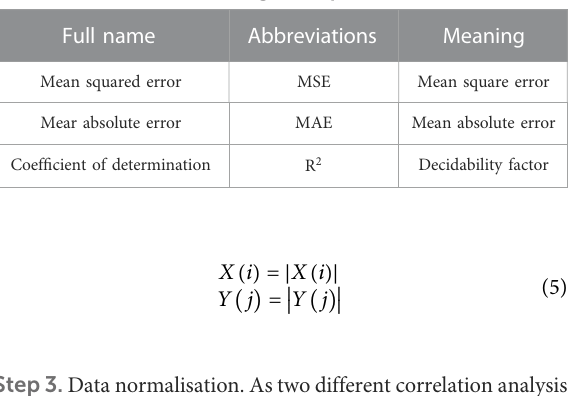
TABLE 1 Evaluation metrics for regression